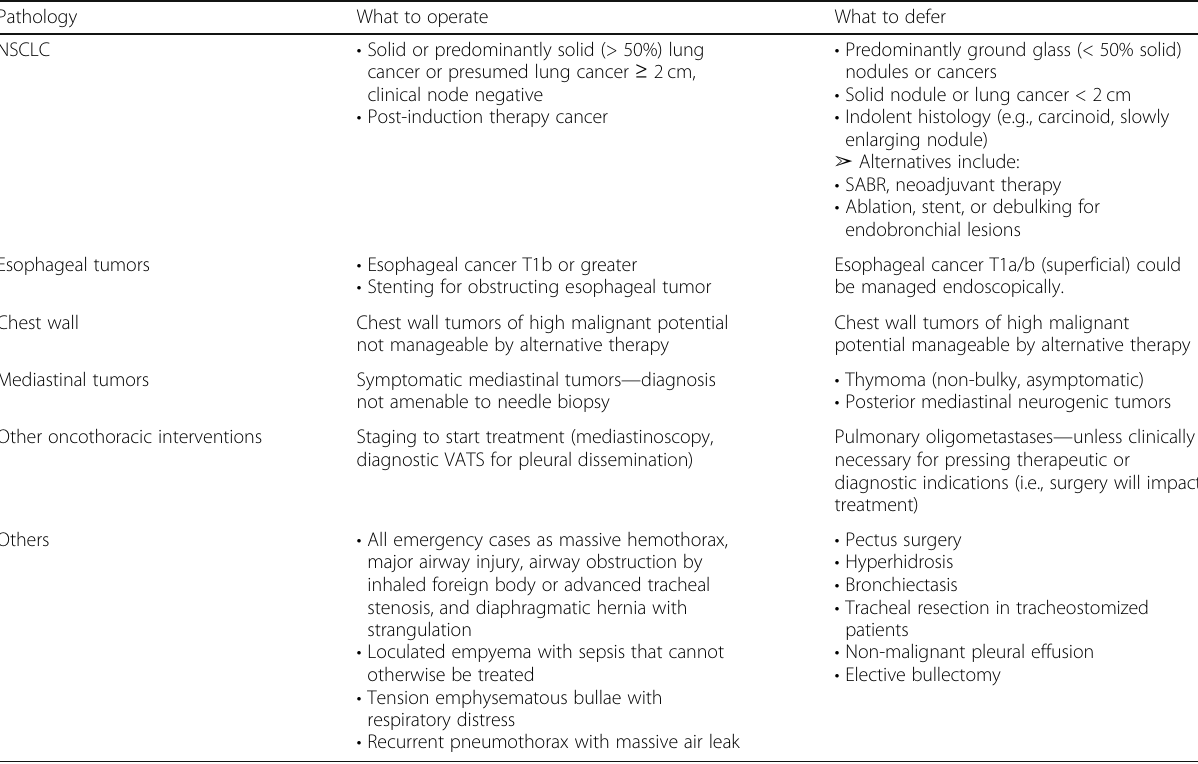
Table 1 Summary for decision-making in different pathologies during phase 1